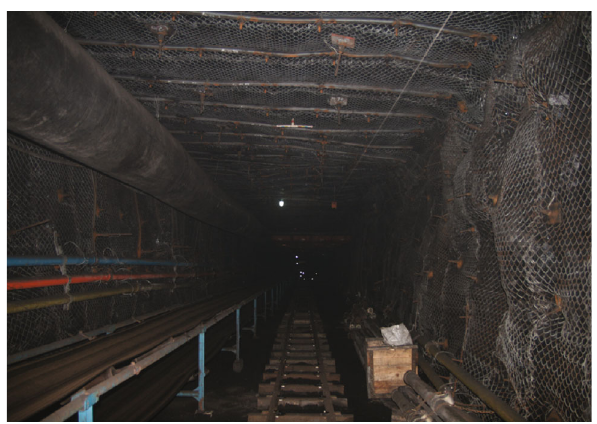
Figure 18: Good result of the support